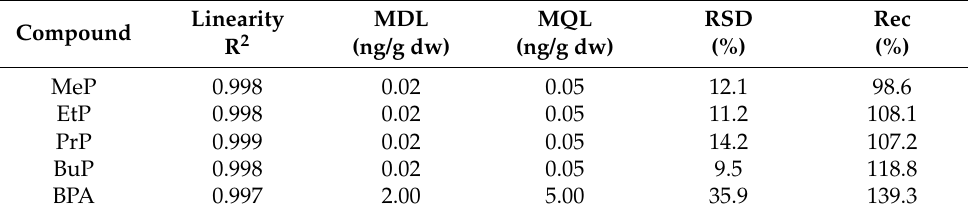
Table 1. Linearity, methodquantificationlimit, precisionandrecoveryofparabensandBPAinguanomatrix.